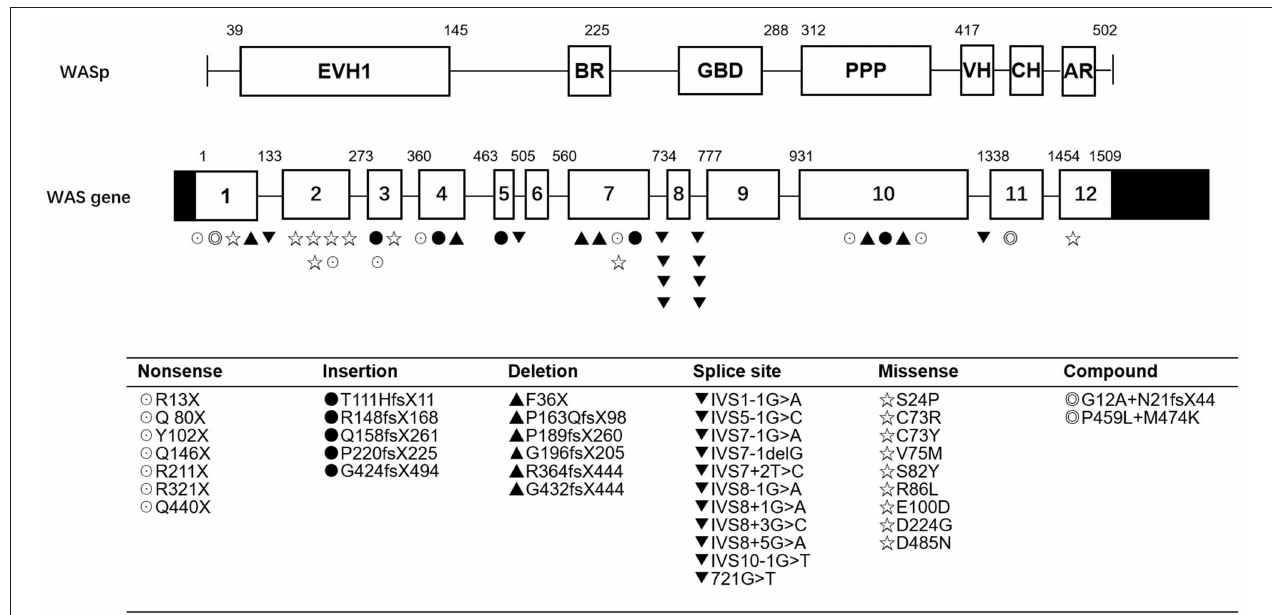
between the WAS/XLT and ITP